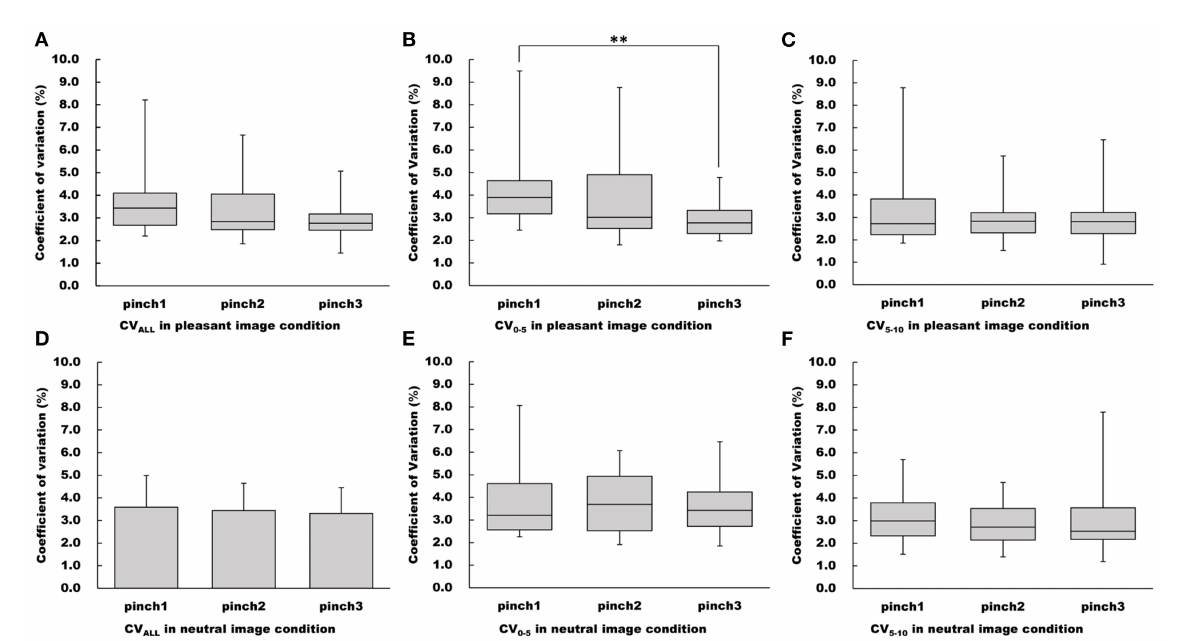
FIGURE6 Changes of CV values in the pleasant and neutral image conditions. (A–C) Show CV ALL , CV 0 − 5 , CV 5 − 10 values in the pleasant image condition, respectfully. (D–F) Show CV ALL , CV 0 − 5 , CV 5 − 10 values in the neutral image condition, respectfully. For parametric data, CV values are represented as mean and standard deviation. For non-parametric data, CV values are represented using the box and whisker plot, with the median shown as the middle horizontal line, the upper and lower quartiles indicated as boxes, and the maximum and minimum indicated as whiskers. The vertical axis shows CV value (%), and horizontal axis shows the specific trial (Pinch 1, 2, and 3). ** p < 0.01.